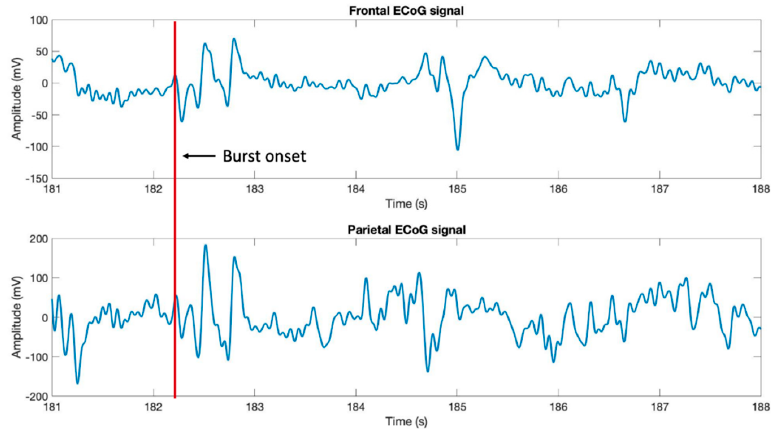
Figure 9. Left frontal and parietal electrocorticogram signals. These recordings show a simultaneous appearance in burst suppression pattern, as marked by the red line.